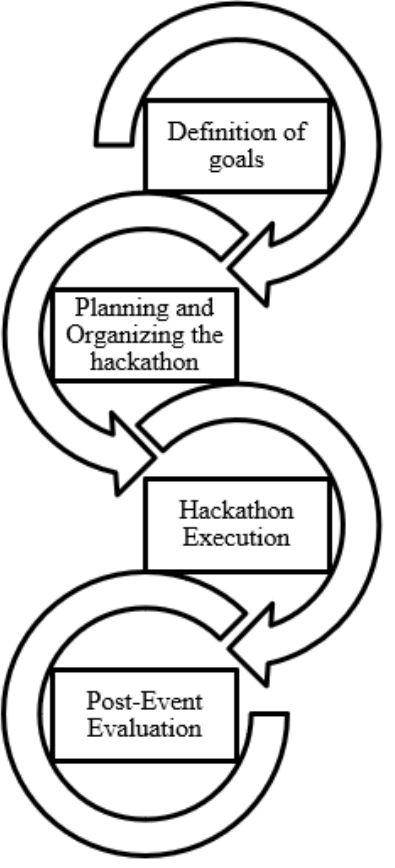
Figure 1. The suggested framework for organizing hackathons.